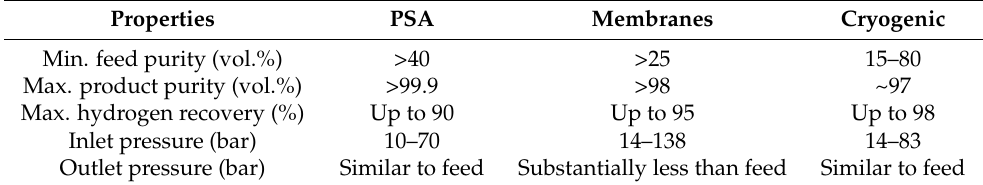
Table 1. Properties of different hydrogen purification processes